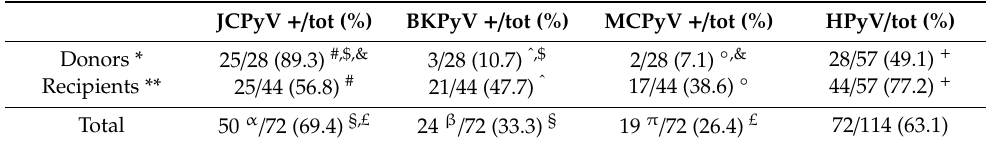
Table 3. Human Polyomavirus (HPyV) prevalence in kidney transplant donors and recipients. JCPyV +/ tot (%) BKPyV +/ tot (%)